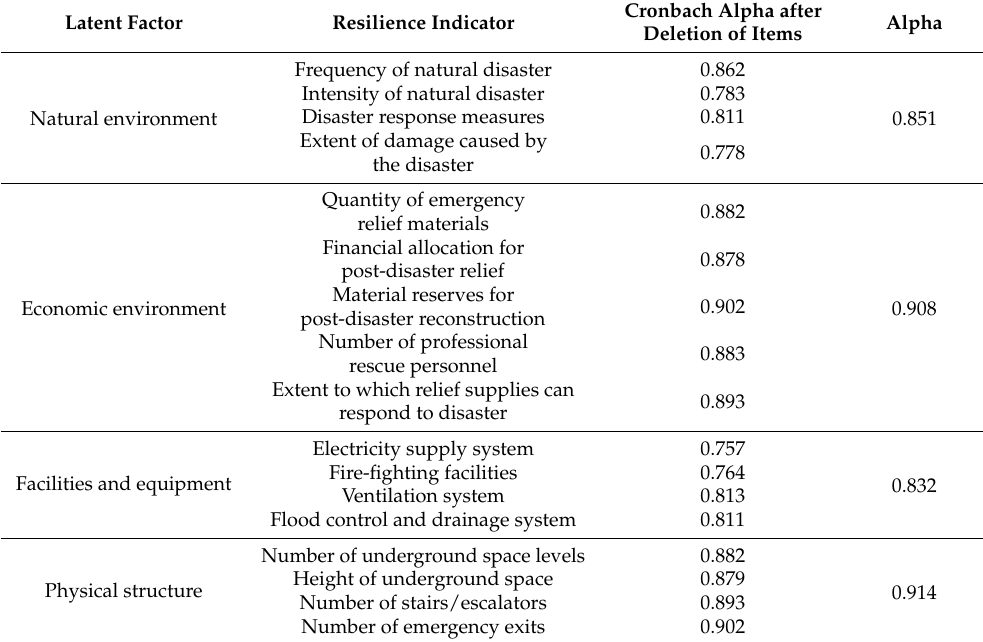
Table 6. Cronbach’s alpha output of the reliability